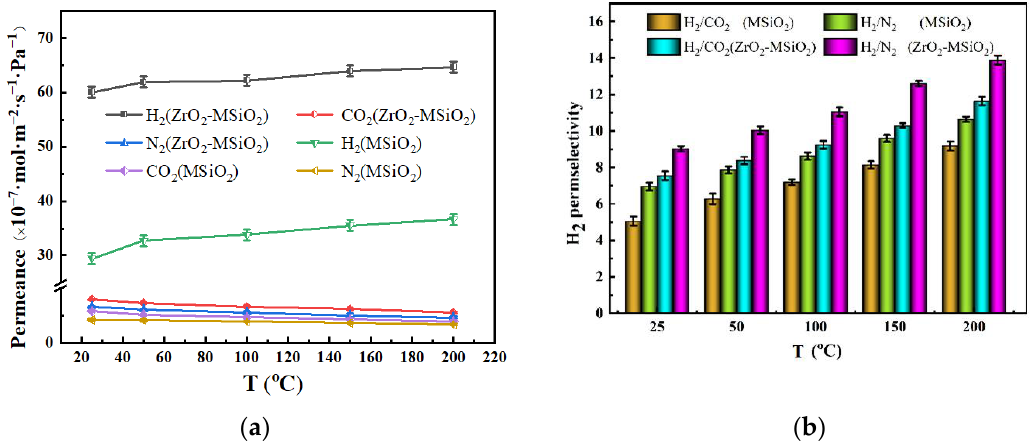
Figure 12. Influence of temperature on the ( a ) gas permeances and ( b ) H 2 permselectivities of MSiO 2 and ZrO 2 -MSiO 2 (n Zr = 0.15) membranes with 0% DCCA addition at a pressure difference of 0.1 MPa.